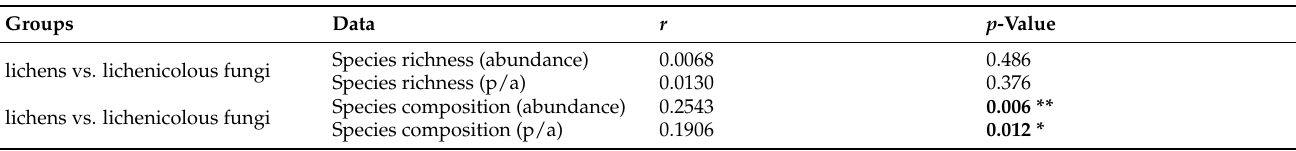
Pearson correlation coefficient ( r ) and its statistical significance among the taxa (** = p -value < 0.01, * = p -value <